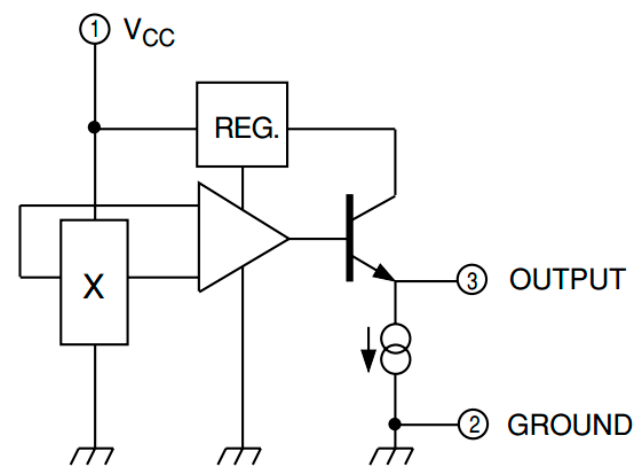
Figure 4. The internal structure of the UGN3503 Hall sensor.